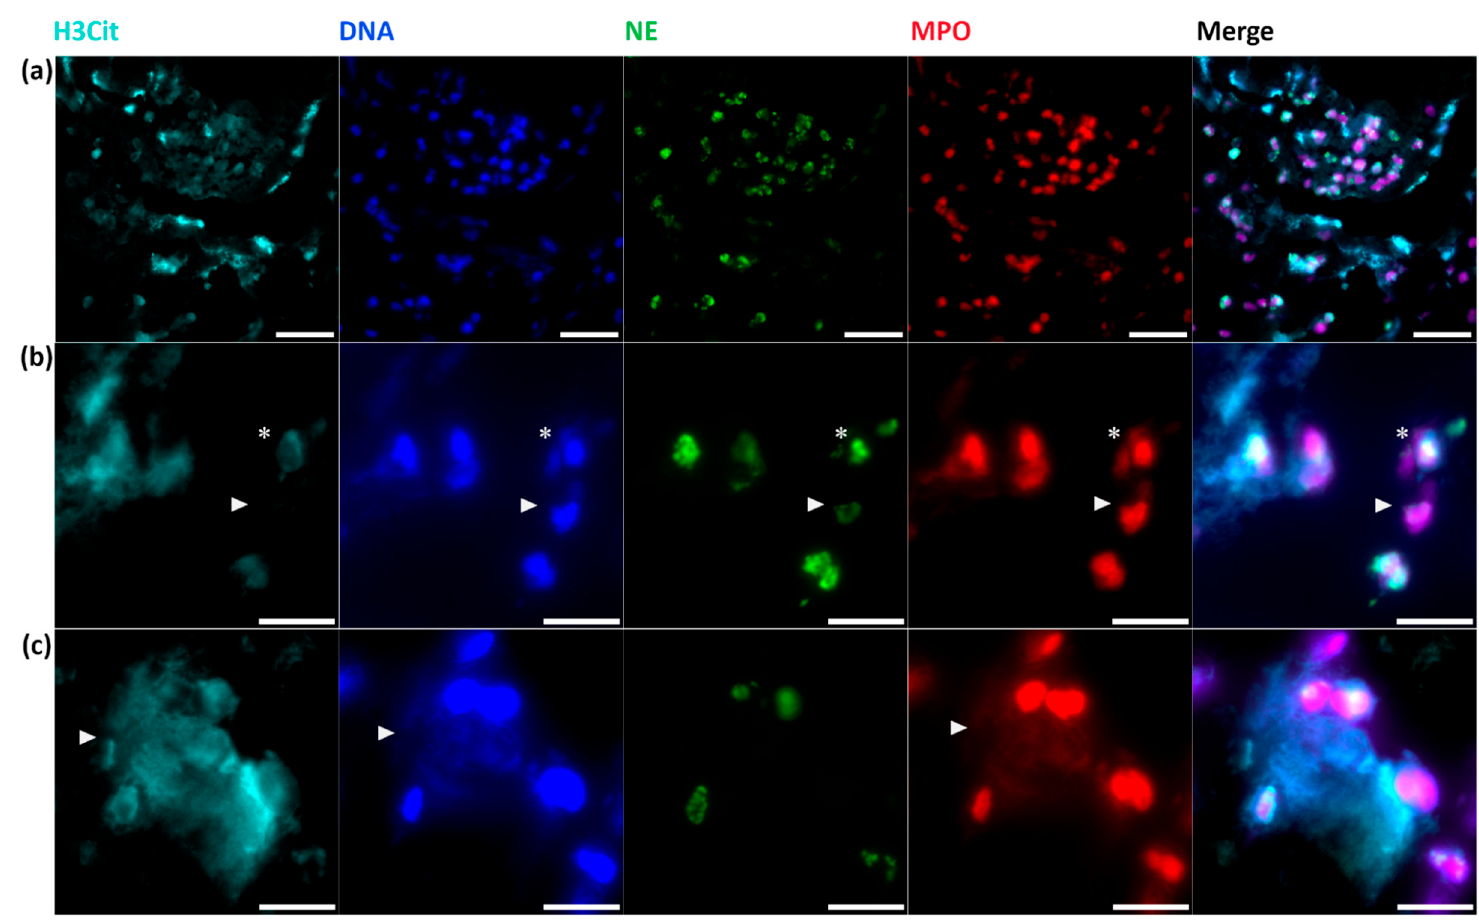
Figure 4. Immunofluorescent staining of NETs. Immunofluorescent co-staining identifies ( a ) large thrombembolus area with co-localization of H3Cit, DNA (by DAPI), NE and MPO. Representative magnifications of ( b ) NETosis (*) and neutrophils without intracellular H3Cit (arrowhead) and ( c ) web-like NETs with co-localization of extracellular H3Cit, DNA and MPO are shown (arrowhead) . Scale bars: ( a ) 20 µm, ( b , c ) 10 µm. NE = neutrophil elastase; MPO = myeloperoxidase, DAPI = 4,6-diamidino-2-phenylindole.